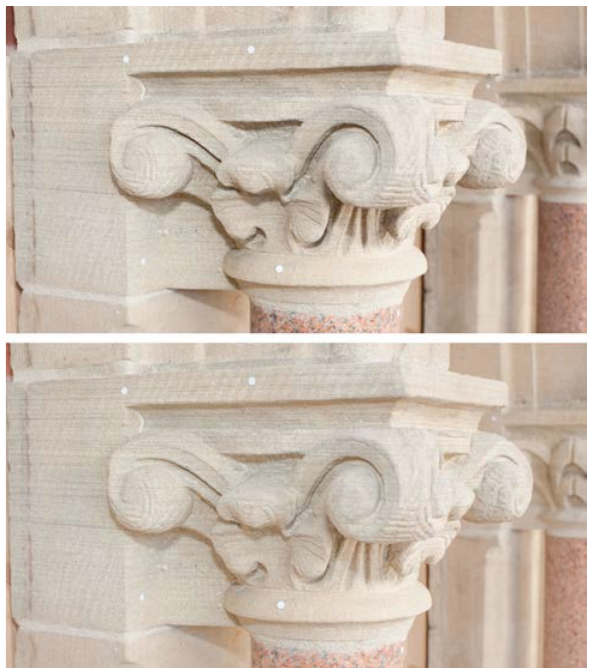
Figure 3. RAW file format images adjusted to gain detail information in shadow